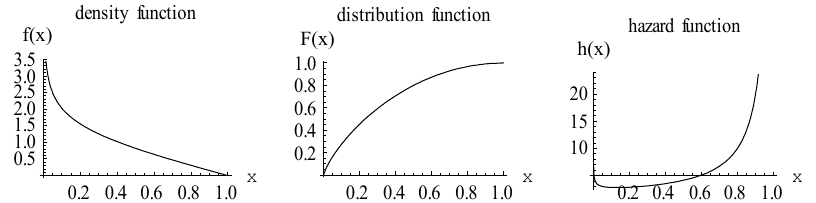
Figure 2 – The density, distribution, and survival functions of the fitted J-shaped distribution for the failure